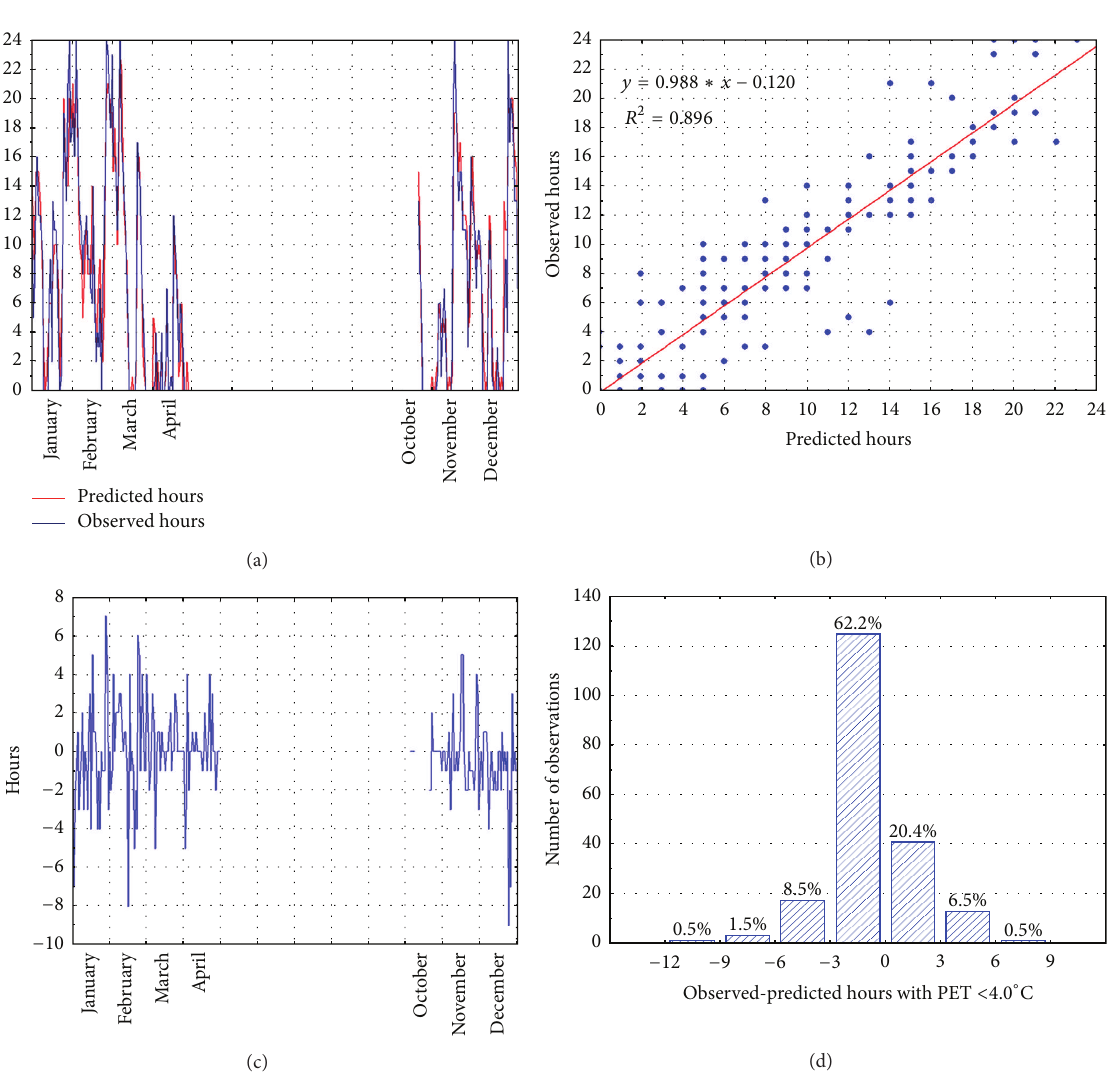
Figure11:Observed versuspredicted hourswith PET < 4.0 ∘ C(a);scatter plotbetween theobserved andpredicted hourswith PET < 4.0 ∘ C(b); observed minus predicted hours with PET < 4.0 ∘ C (c) and histogram with the absolute differences between the observed and the predicted hours with PET < 4.0 ∘ C (d). One day ahead prognosis. Cold period of